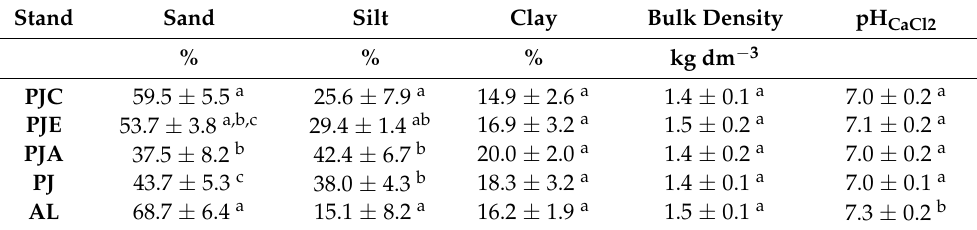
Table 1. Soil particle-size distribution, bulk density, and pH of the investigated tree stands and the arable land. Site labels: PJ = white poplar and common walnut; PJC = PJ intercropped with common hazel; PJA = PJ intercropped with Italian alder; PJE = PJ intercropped with autumn olive; AL = agricultural land. Values are mean and standard deviation ( n = 5 for soil particle-size distribu- tion and 15 for bulk density and pH). Superscript letters indicate significant differences within means in the column according to one-way ANOVA at p ≤ 0.05 and Tukey’s test. Stand Sand Silt Clay Bulk Density pH CaCl2